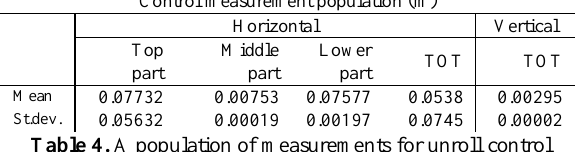
Table 4. A population of measurements for unroll control between 3D model and developed surface.